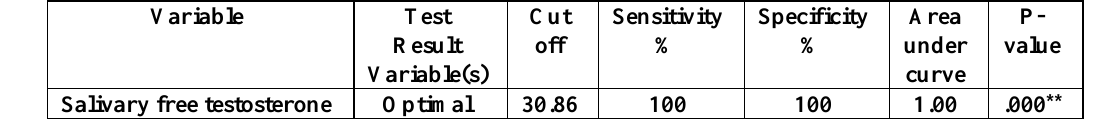
Table 3: Correlation coffecient between salivary free testosterone with plaque index, gingival index among the study and control groups. Variable Study Control PlI GI PlI GI Free testosterone (pg/ml) P r P r P -0.01 # 0.98 -0.08 0.69 # -0.11 # 0.54 0.15 # 0.43 # = not significant at P>0.05 Table 4: Cutoff point, sensitivity, specificity and area under curve of salivary free testosterone. Variable Test Cut Sensitivity Specificity Area P- Result off % % under value Variable(s) curve Salivary free testosterone Optimal 30.86 100 100 1.00 .000